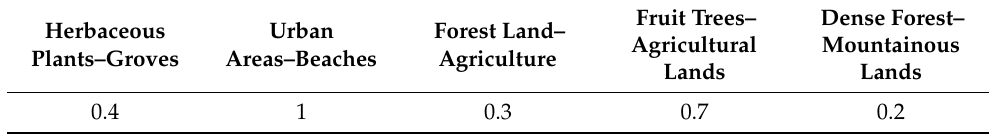
Table 7. Estimation of parameter, X a for the Babolroud watershed.